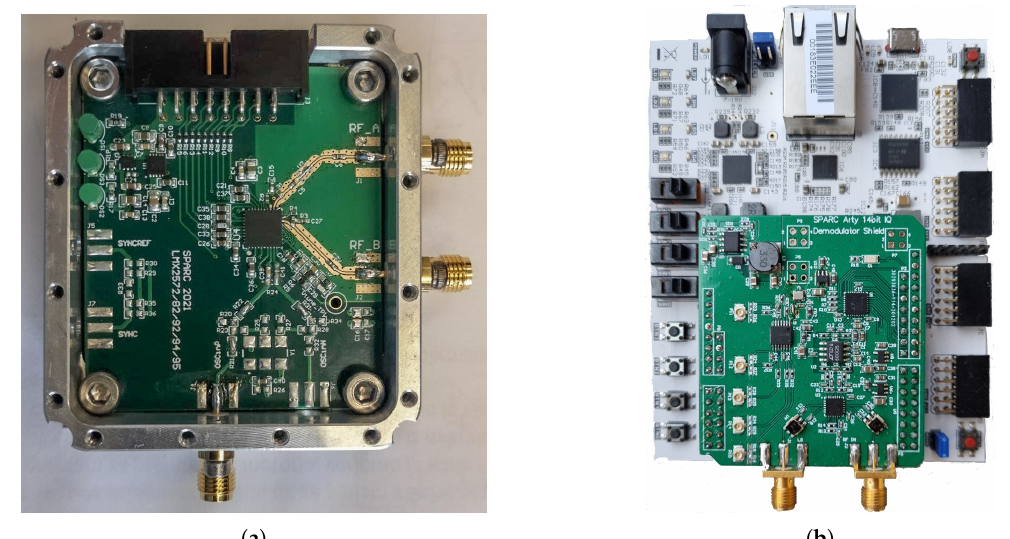
Figure 3. Main developed hardware of the proposed super-heterodyne architecture SFCW with EC system ( a ) The synthesizer board ( b ) The digital IQ demodulator board with the FPGA process- ing